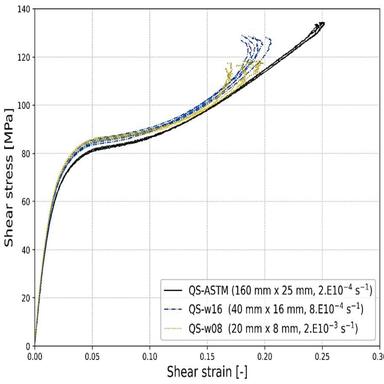
Quasi-static in-plane shear stress-strain data for three different ± 45◦ tensile specimen geometries.